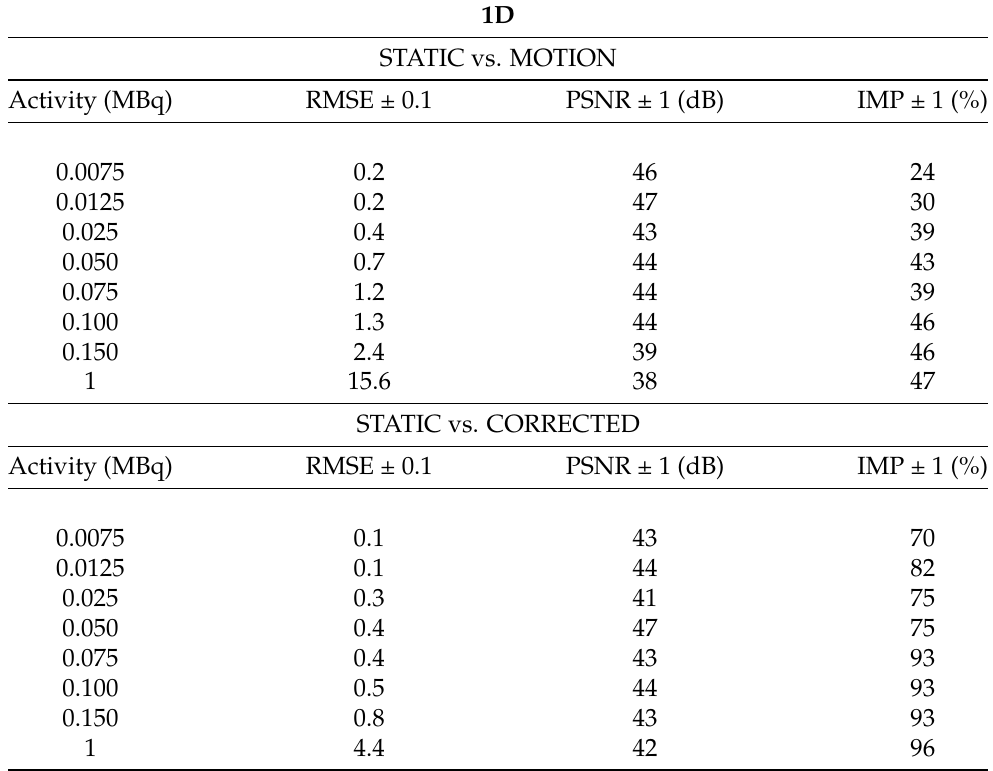
Table 4. RMSE, IMP, and peak signal-to-noise ratio (PSNR) values for a sinusoidal motion in one dimension for different source activities.